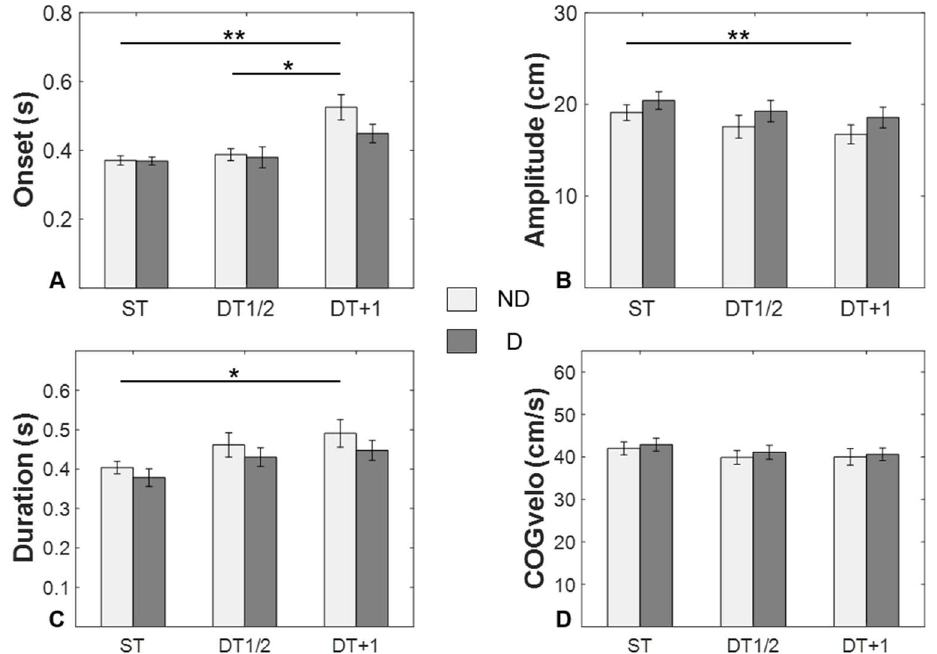
Figure 3. Comparison of measurement parameters between dominant (D) and non-dominant (ND) limbs and under different task conditions (single-task (ST), dual-task 1/2 (DT1/2), and dual task +1 (DT + 1)). The measurement parameters consisted of APA onset ( A ), APA amplitude ( B ), APA duration ( C ), and COG velo ( D ). Values are mean ± standard error. There were significant post hoc comparisons (Holm–Bonferroni adjusted for multiple comparisons): * p < 0.05; ** p <